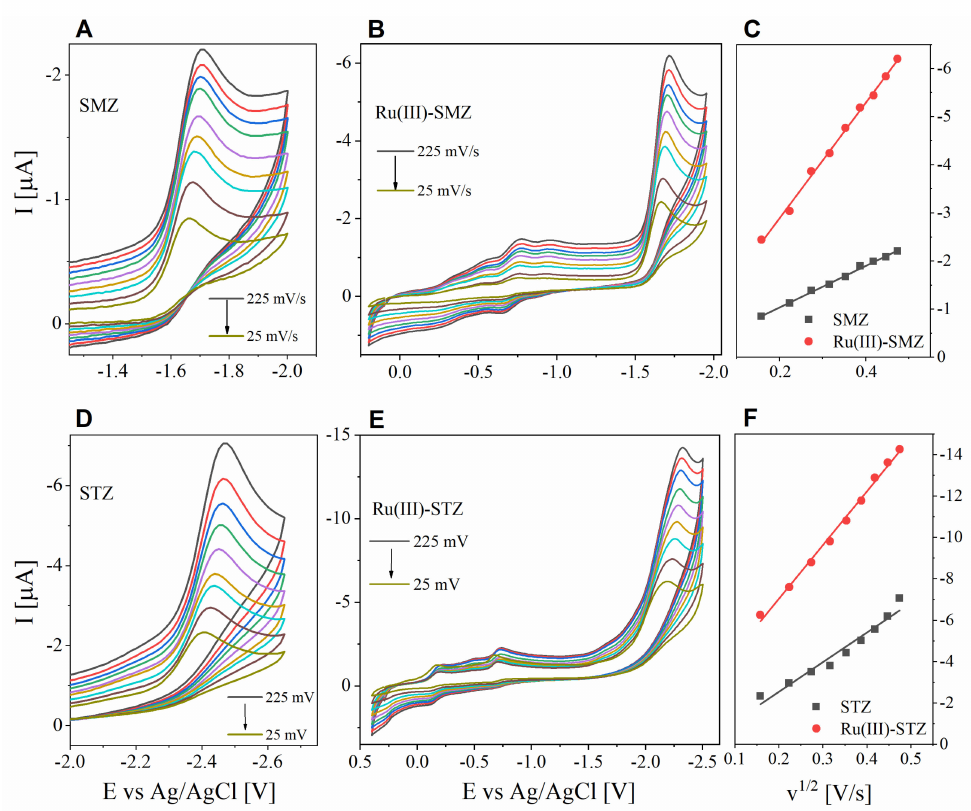
Figure 7. Voltammograms in DMSO registered for ( A ) SMZ, ( B ) Ru(III)-SMZ, ( D ) STZ, ( E ) Ru(III)-STZ, registered at different values of scan rate (from 25 mV · s − 1 to 225 mV · s − 1 ). Plots of reduction current I vs. v 1/2 for ( C ) ( (cid:4) ) SMZ (r 2 = 0.998) and ( • ) Ru(III)-SMZ (r 2 = 0.999) and ( F ) ( (cid:4) ) STZ (r 2 = 0.950) and ( • ) Ru(III)-STZ (r 2 =